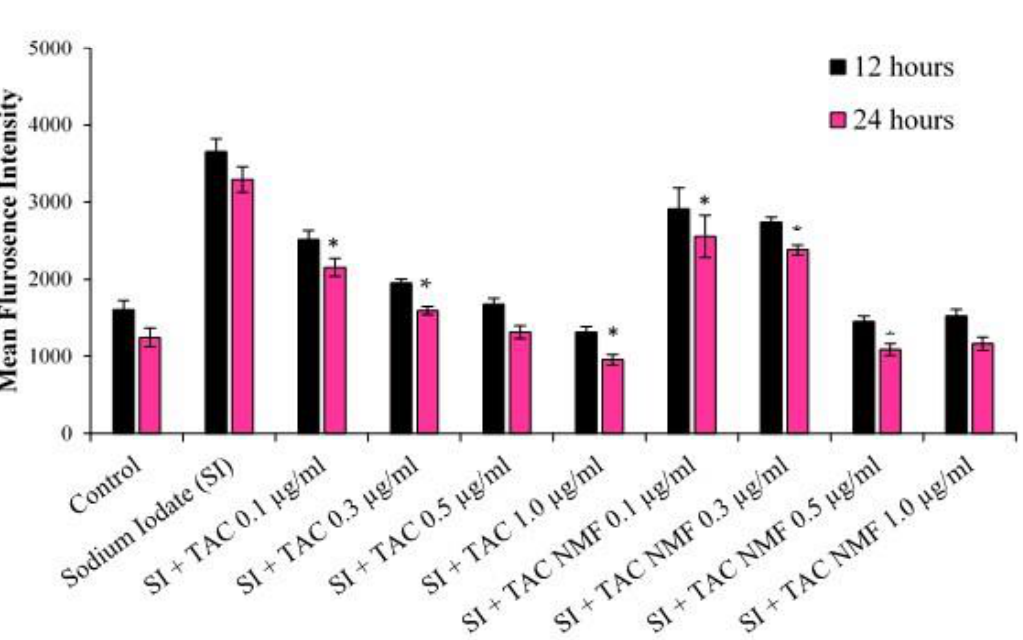
Figure 15. Evaluation of formation of Reactive Oxygen Species (ROS) in D407 retinal pigment epithelium cells pretreated with Sodium Iodate (SI) after treatment with TAC-NMF and TAC by DCFDA Assay. D407 cells treated with SI 10 ug / mL for 6 h followed by treatment of TAC (0.1, 0.3, 0.5, 1.0 ug / mL) and TAC-NMF (0.1, 0.3, 0.5, 1.0 ug / mL) for 12 and 24 h. After the treatment, ROS was measured by DCFDA dye and the ROS was determined by FACS. Results are expressed as mean of three independent experiments, n = 3 ± SD. (* p ≤ 0.05 as compared to 12 h * p ≤ 0.05 as compared between